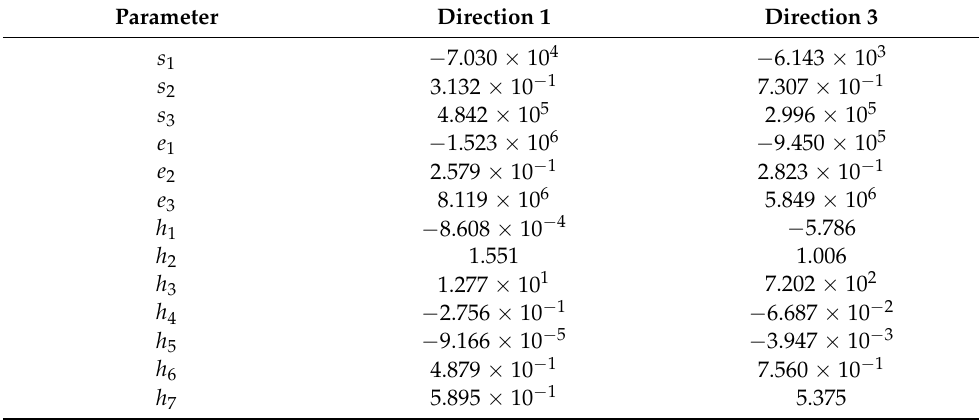
Table A1. Fitting parameters used in the UMAT